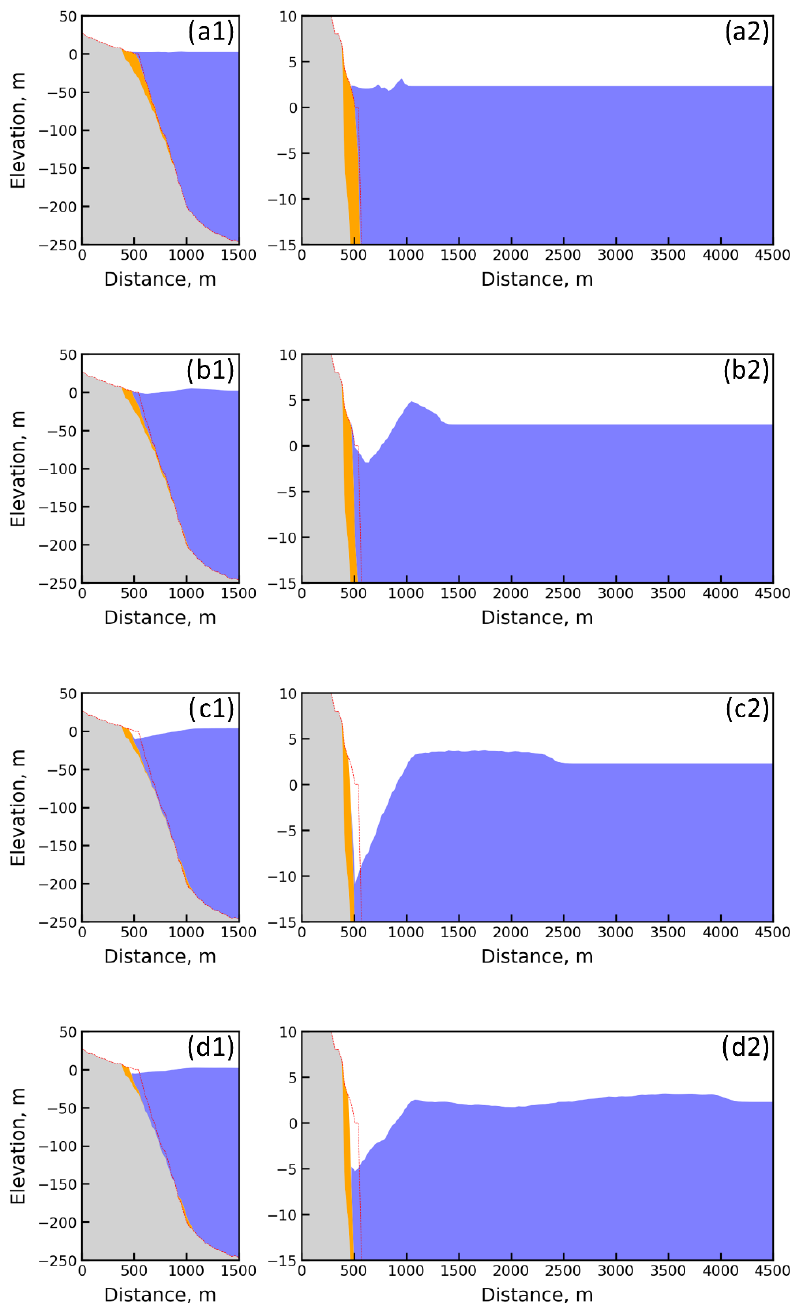
Figure C1. Temporal evolution of the 2018 Sulawesi–Palu tsunami wave (a) 2, (b) 10, (c) 30, and (d) 60s after the S8 landslide. The red line is the topography and bathymetry before S8 landslide (Pakoksung et al.,